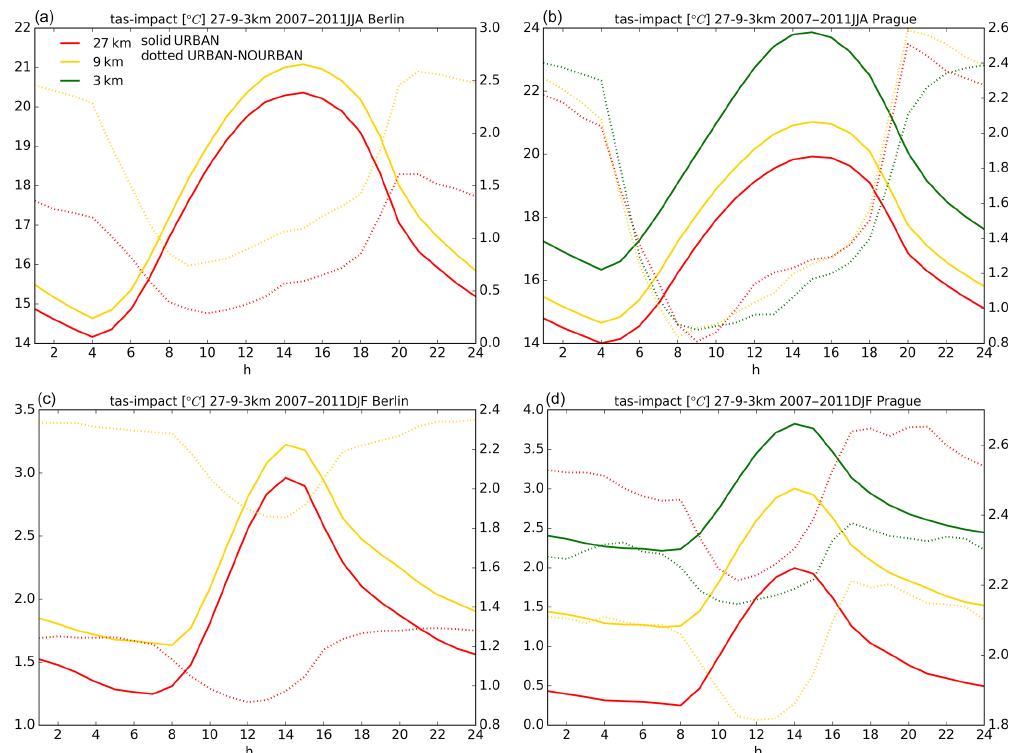
Figure 10. Impact of urban surfaces on near-surface temperature diurnal cycle in ◦ C for JJA (a, b) and DJF (c, d) for the three resolutions (27km – red, 9km – orange and 3km – dark green). Solid lines are the absolute values (left-hand y axis) from the URBAN model experiment; dashed lines represent the urban impact (right-hand y